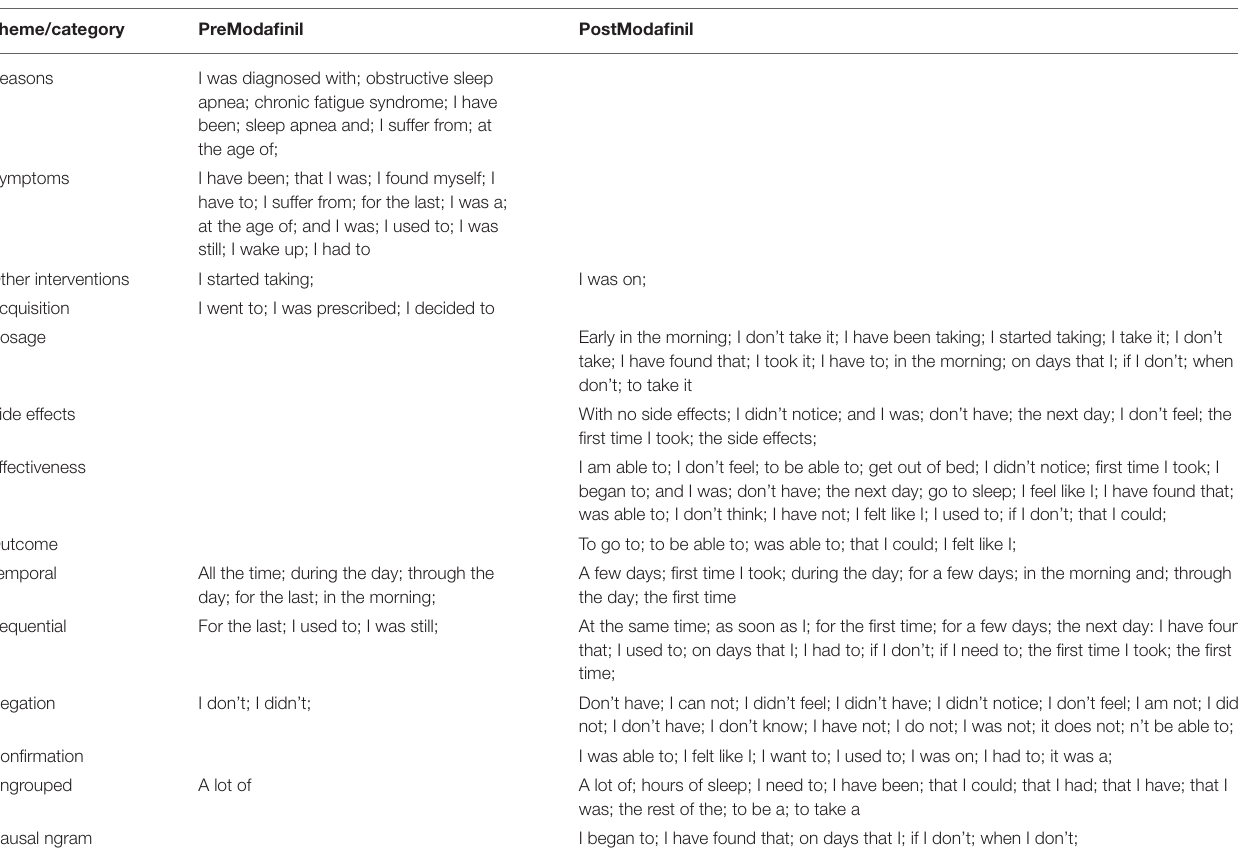
TABLE 8 | PreModafinil and PostModafinil 3–5-word ngrams grouped by theme.